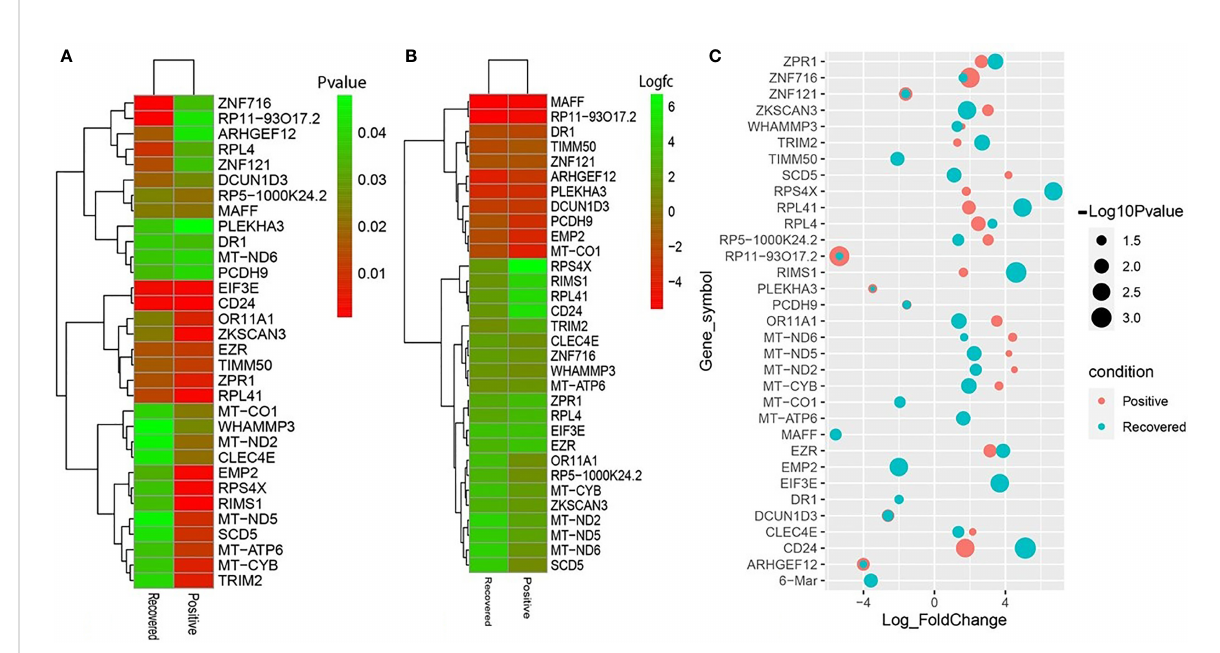
FIGURE 3 Heatmaps depicting the relationships among common DEGs in COVID-19 patients and recovered subjects based on (A) adjusted p -value and (B) logFC values. (C) Bubble plots showing the combined Log 10 fold-changes and p -values for the shared common genes between COVID-19 patients and recovered humans. The red color indicates the genes of COVID-19 patients, and the green color presents the genes of the recovered people, while the mixed color indicates the overlapping genes.